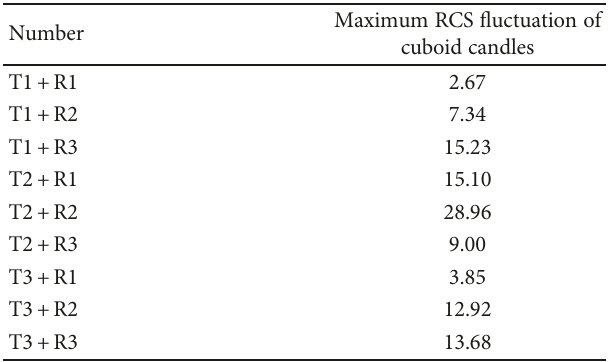
Table 5: The di ff erence between the maximum and minimum values of RCS fl uctuation by means of MIMO (units: dB).